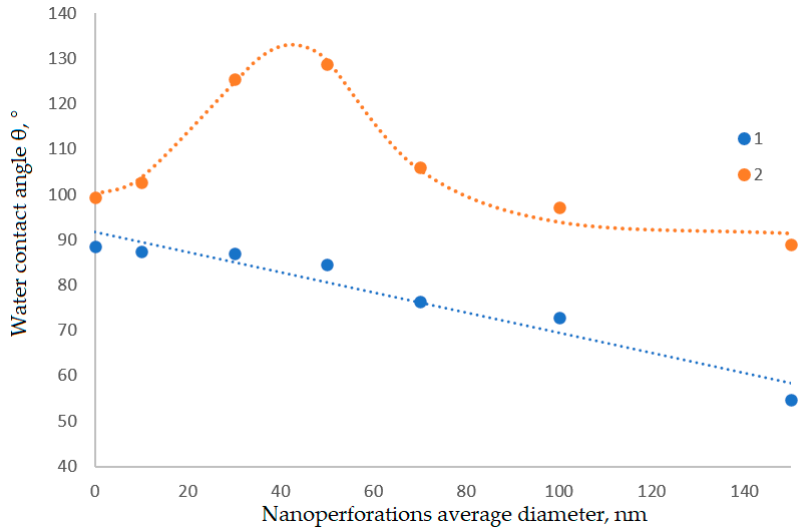
( 5 ) Figure 9. Pictures of polymer films on aluminum samples: ( 1 )—polymethylmethacrylate film on untreated aluminum; ( 2 )—polymethylmethacrylate film on anodized aluminum; ( 3 )—polytetraflu- oroethylene copolymer film on anodized aluminum; ( 4 )—polyhexafluoropropylene film on ano- dized aluminum surface; ( 5 )—polyhexafluoropropylene film on modified and anodized aluminum surface. Sample 1 shows that polymethylmethacrylate (PMMA) did not attach to untreated aluminum surface at all. Sample 2 shows even attachment of PMMA to anodized alumi- num surface. Sample 3 is an unevenly attached layer of PTFE copolymer on anodized alu- minum surface. PTFE has significantly lower surface free-energy and it takes additional effort to provide proper adhesion on desirable surfaces. Sample 4 is a PHFP layer that has completely detached from the anodized aluminum surface during the drying process. In contrast, the PHFP film on the modified and anodized aluminum surface adhered very